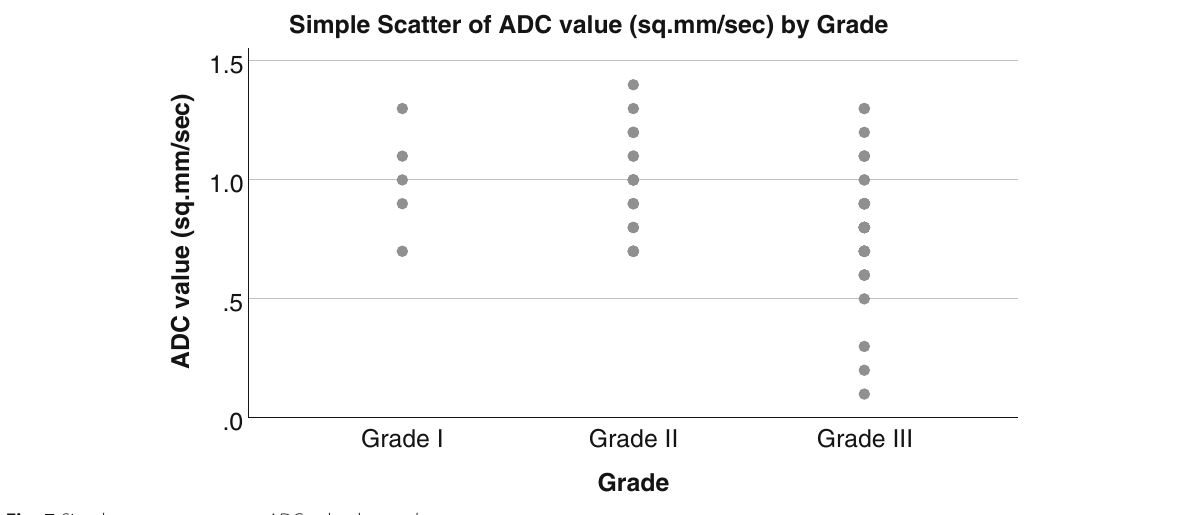
ROC Curve: ADC cutoff to discriminate G III from G I + G II)